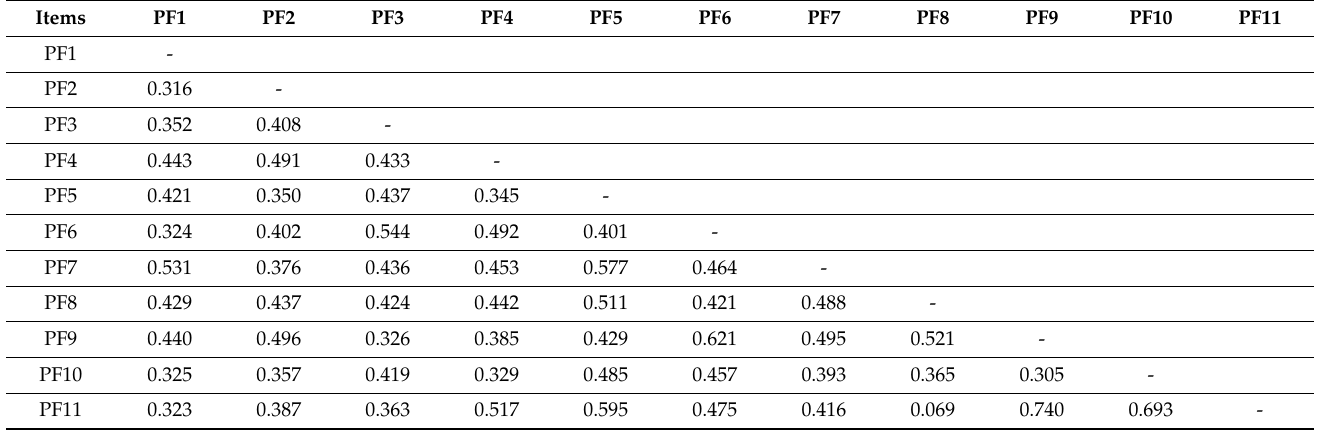
Table 3. Inter-item correlation matrix for Ar-KOOS-PF-F.